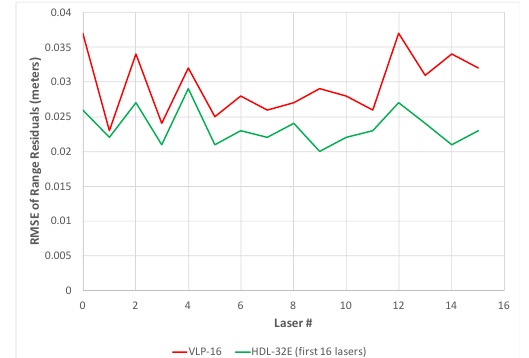
Figure 5: Comparison of Range Residuals by Laser for VLP-16 and HDL-32E after static